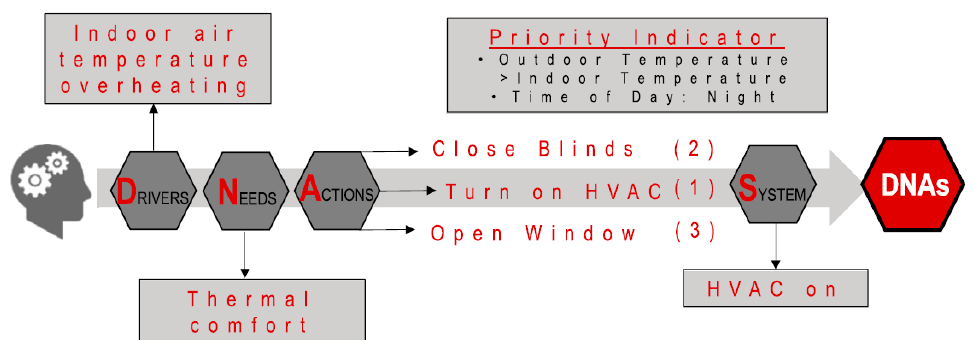
Figure 17. Example of priority indicators in DNAs Framework [136] (Reprinted from Elsevier Building and Environment, Volume 94, Part 1, Tianzhen Hong, Simona D’Oca, Sarah C. Taylor-Lange, William J.N. Turner, Yixing Chen, Stefano P. Corgnati, An ontology to represent energy-related occu- pant behavior in buildings. Part II: Implementation of the DNAS framework using an XML